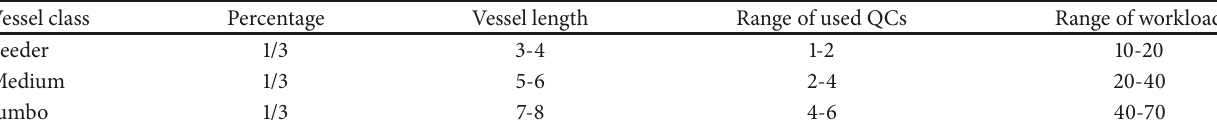
Table 3: Specifications of different types of